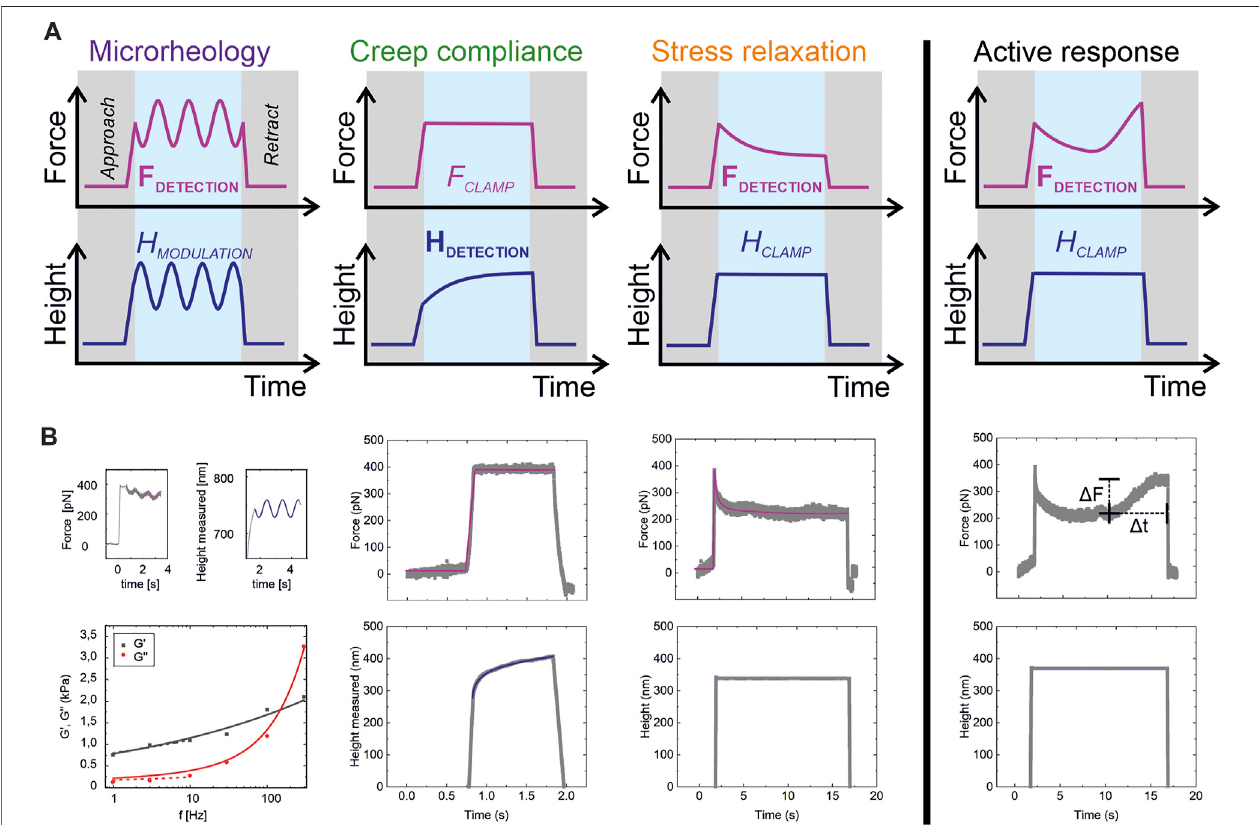
FIGURE 2 | Methods and raw data. (A) Overview of the rheological test protocols used in this study, where either force or cell height are imposed, and the other parameters are measured. (B) Raw data from the tests in (A) . Fits of Eqs 1 , 6 , 7 , and 10 to data are in color; force (magenta), height (blue). G ′ over full frequency range: black line, G ′ over 1 – 10 Hz (approximated with single power law): dashed black line. G ″ over full frequency range: red line. G ″ over 1 – 10 Hz (approximated with single power law): dashed red line.